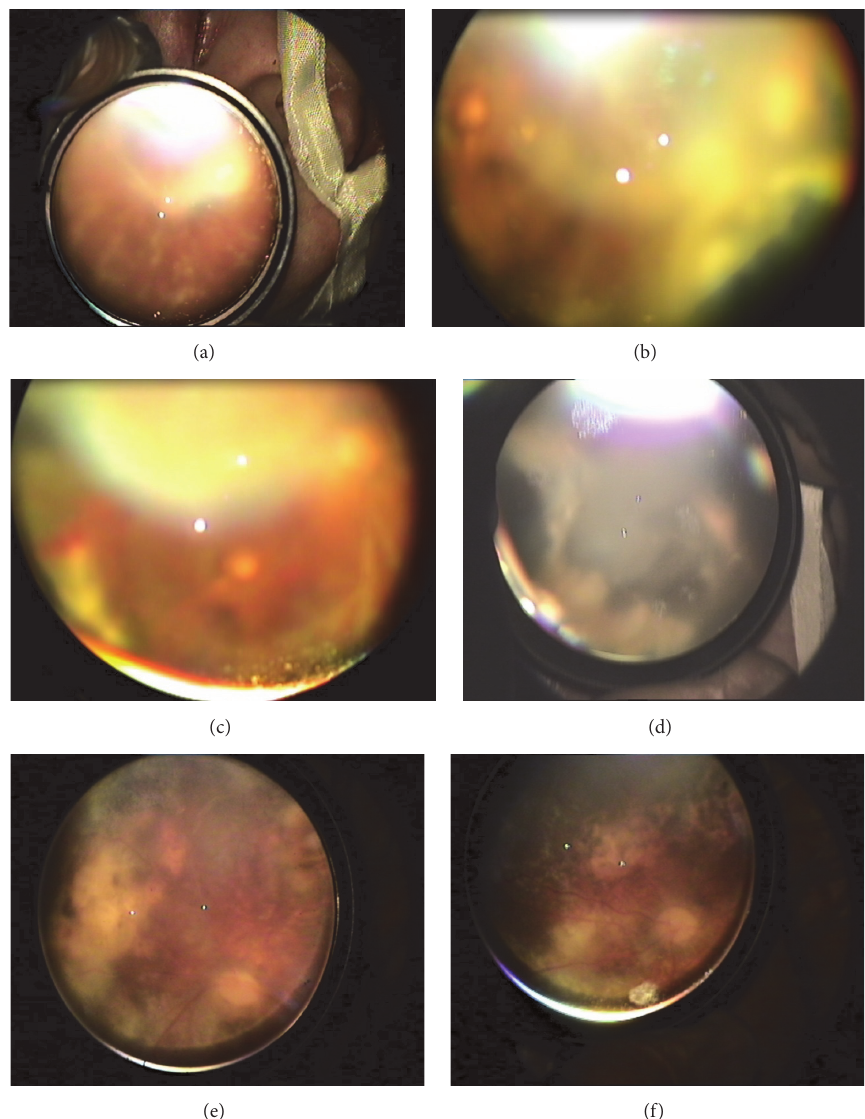
Figure 1: Color fundus images of the eye. (a) Periphlebitis and vascular sheathing, (b) peripheral retinal necrosis and foveal atrophy, (c) moderate vitritis, retinal hemorrhage, and necrotizing retinitis, (d) white-black colored, diffuse necrotizing retinitis, and (e), (f) after ganciclovir treatment, resolved signs of moderate vitritis, vascular sheathing and periphlebitis, and existing of paled optic